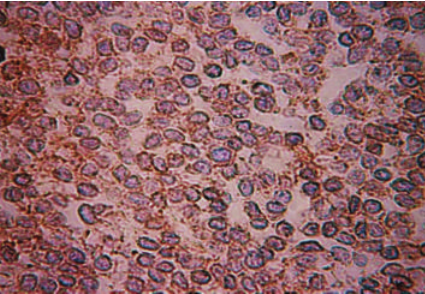
Figure 4: PNET arising in the liver: the tumor cells show immunoreactivity for CD99, streptavidin-biotin,